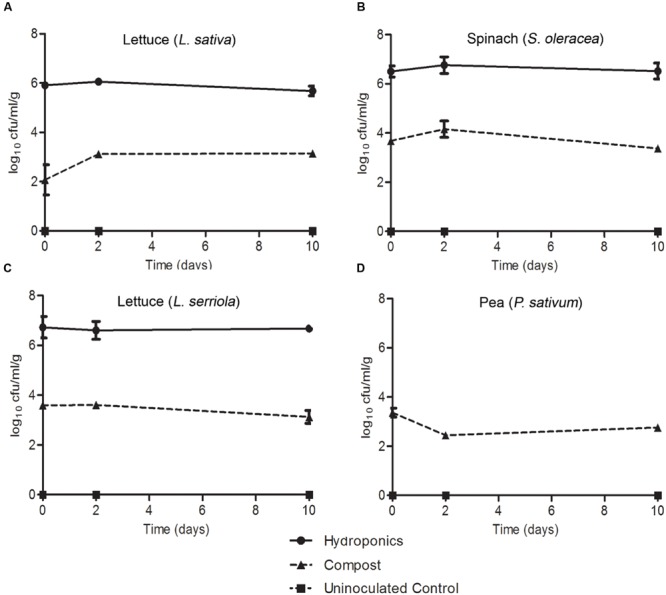
Escherichia coli O157:H7 (Sakai) on roots. The numbers of E. coli O157:H7 (Sakai) recovered from the roots of roundhead lettuce (L. sativa; A), spinach (S. oleracea; B), wild prickly lettuce (L. serriola; C), and vining green pea (P. sativum; D), following inoculation of the compost (triangles) or hydroponics liquid media (circles). P. sativum was not grown under hydroponics conditions. Bacteria were not recovered from the hydroponic media-only control (squares). The average and the standard error of the mean for each of the time points is expressed as the number recovered per gram of fresh tissue (Log10). Data is generated from nine replicate samples and was analyzed by one-way ANOVA with the Tukey multiple comparison test.